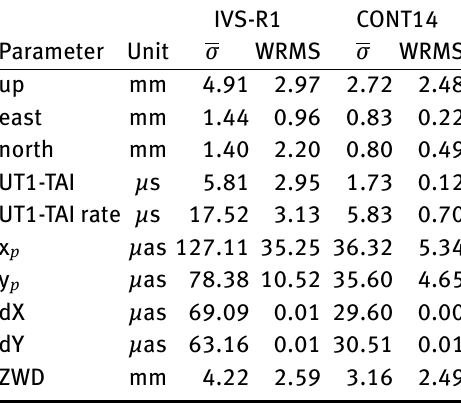
Table 2: Comparison of geodetic parameters derived from On and Od data. Presented are mean formal errors ( σ ) of the parameters, and the weighted root mean square (WRMS) differences between On and Od results of topocentric station positions (up, east, north), Earth rotation angle and its rate (UT1-TAI, UT1-TAI rate), polar motion (x p , y p ), celestial pole offsets (dX, dY), and zenith wet delays